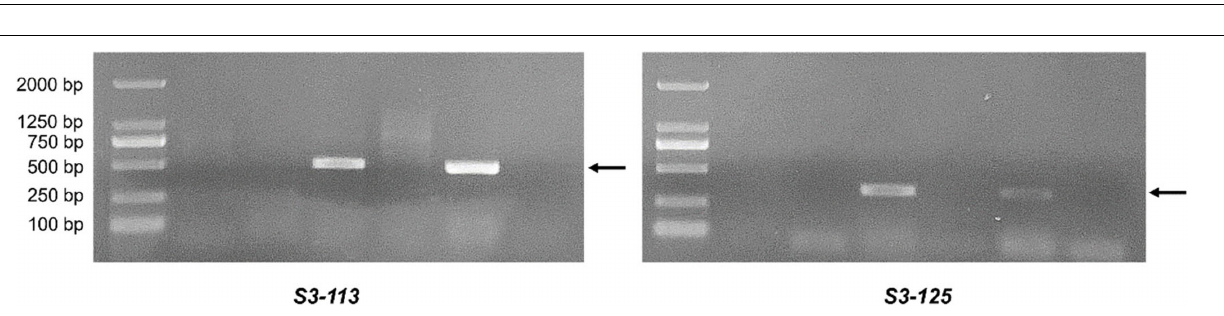
FIGURE 4 | Expressed sequence tag–sequence tagged site (EST-STS) markers analysis of DH109 and DM131. Ten pairs of markers all belonging to the 3rd homoeologous group could amplify Ns genome–specific bands in two derived lines and their alien parents. Among them, marker BE605103 , BE637806 , and BF291730 amplified P. huashanica Ns genome–specific bands only in DH109, marker CD452402 and CD454575 amplified L. mollis Ns genome–specific bands only in DM131 and marker BF200774 , BF429203 , BM137713 , BG263365 , and CD454086 amplified Ns genome–specific bands simultaneously in DH109 and DM131. Lane M, DL2000 marker; lane 1, common wheat 7182; lane 2, Trs-372; lane 3, DH109; lane 4, DM131; lane 5, P. huashanica ; lane 6, L. mollis . Arrows indicate the additional Ns genome–specific bands. P meant P. huashanica Ns genome–specific bands and L meant L. mollis Ns genome–specific bands.